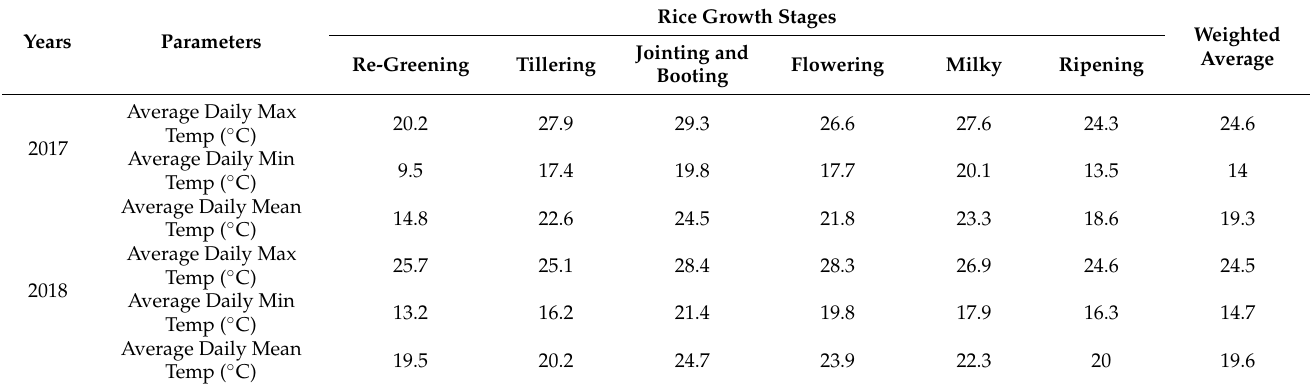
Table 2. Air temperature during each growth stage of rice in 2017 and